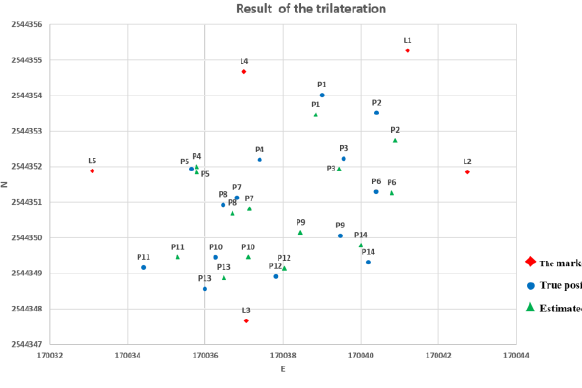
Figure12. The result of the trilateration Table4. The accuracy of the